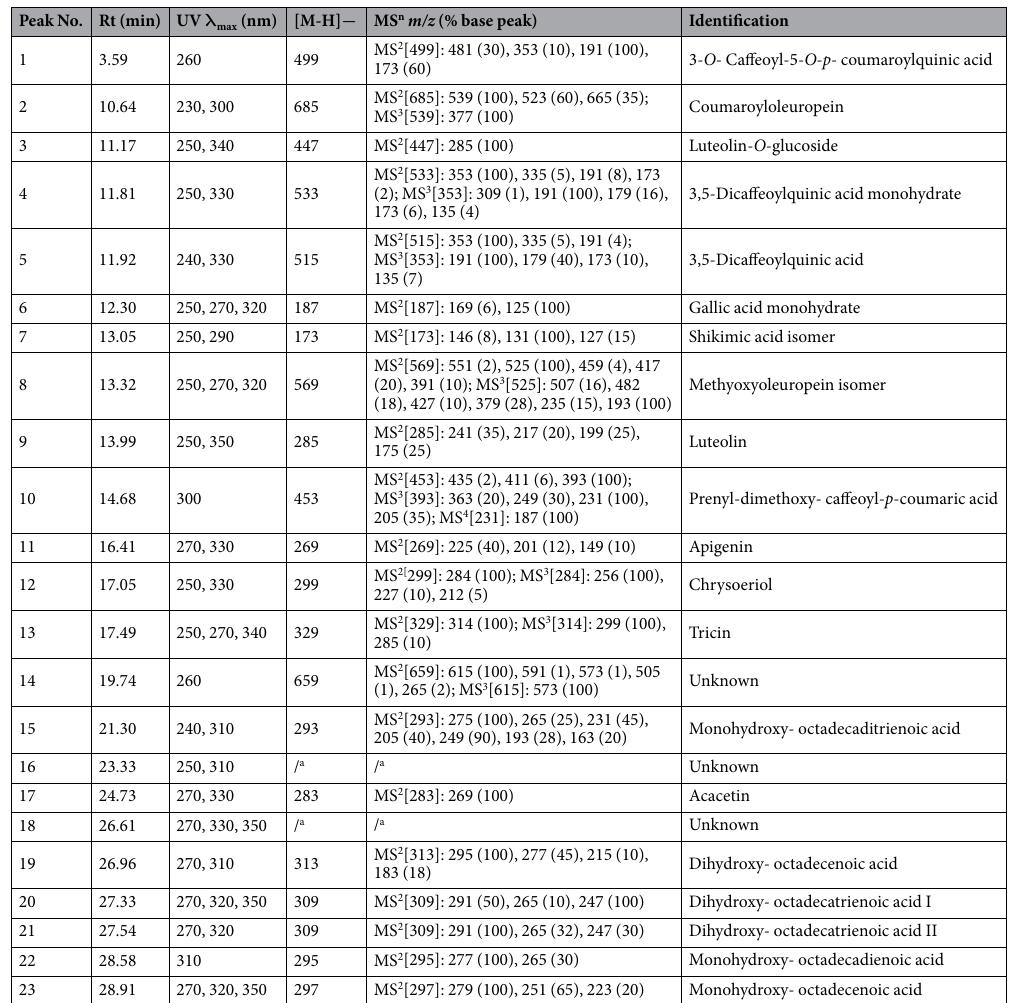
Table 3. HPLC-MS n information on phenolic compounds and hydroxy fatty acids identification in D . indicum var. aromaticum flower. a No data